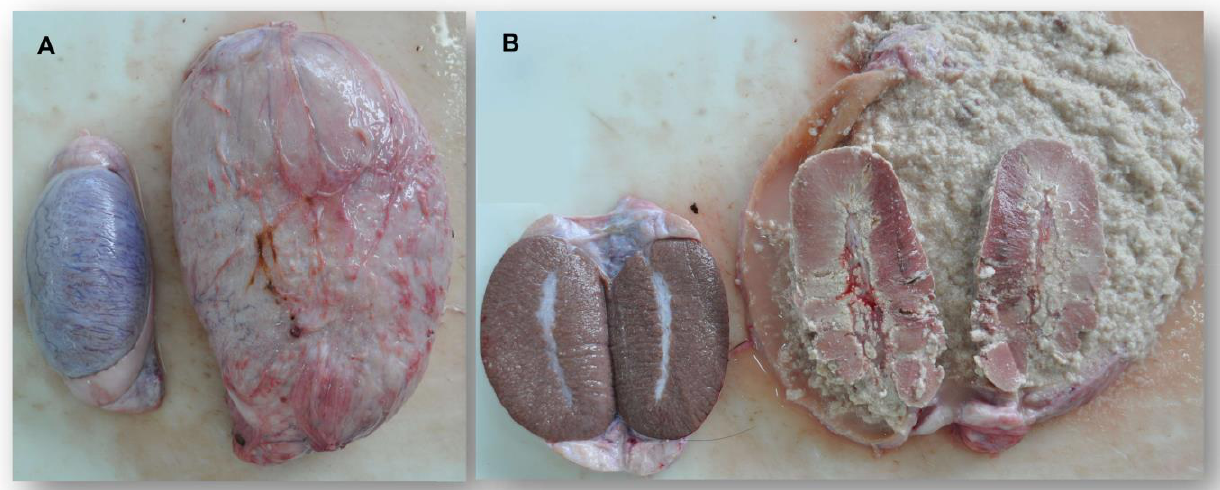
Figure 2. Macroscopic view of both testicles originating from a wild boar infected with Brucella : ( A ) the left testicle reveals a regular size and the right one is noticeably enlarged. ( B ) After dissection of the organs, the left testicle displays a physiological nature. The right testicle and epididymis are eminently enlarged and show signs of necrosis, as well as an accumulation of a large amount of purulent exudate. Table 2. Results on the Brucella PCR-positive wild boars in Bavaria from 2019 to 2021.